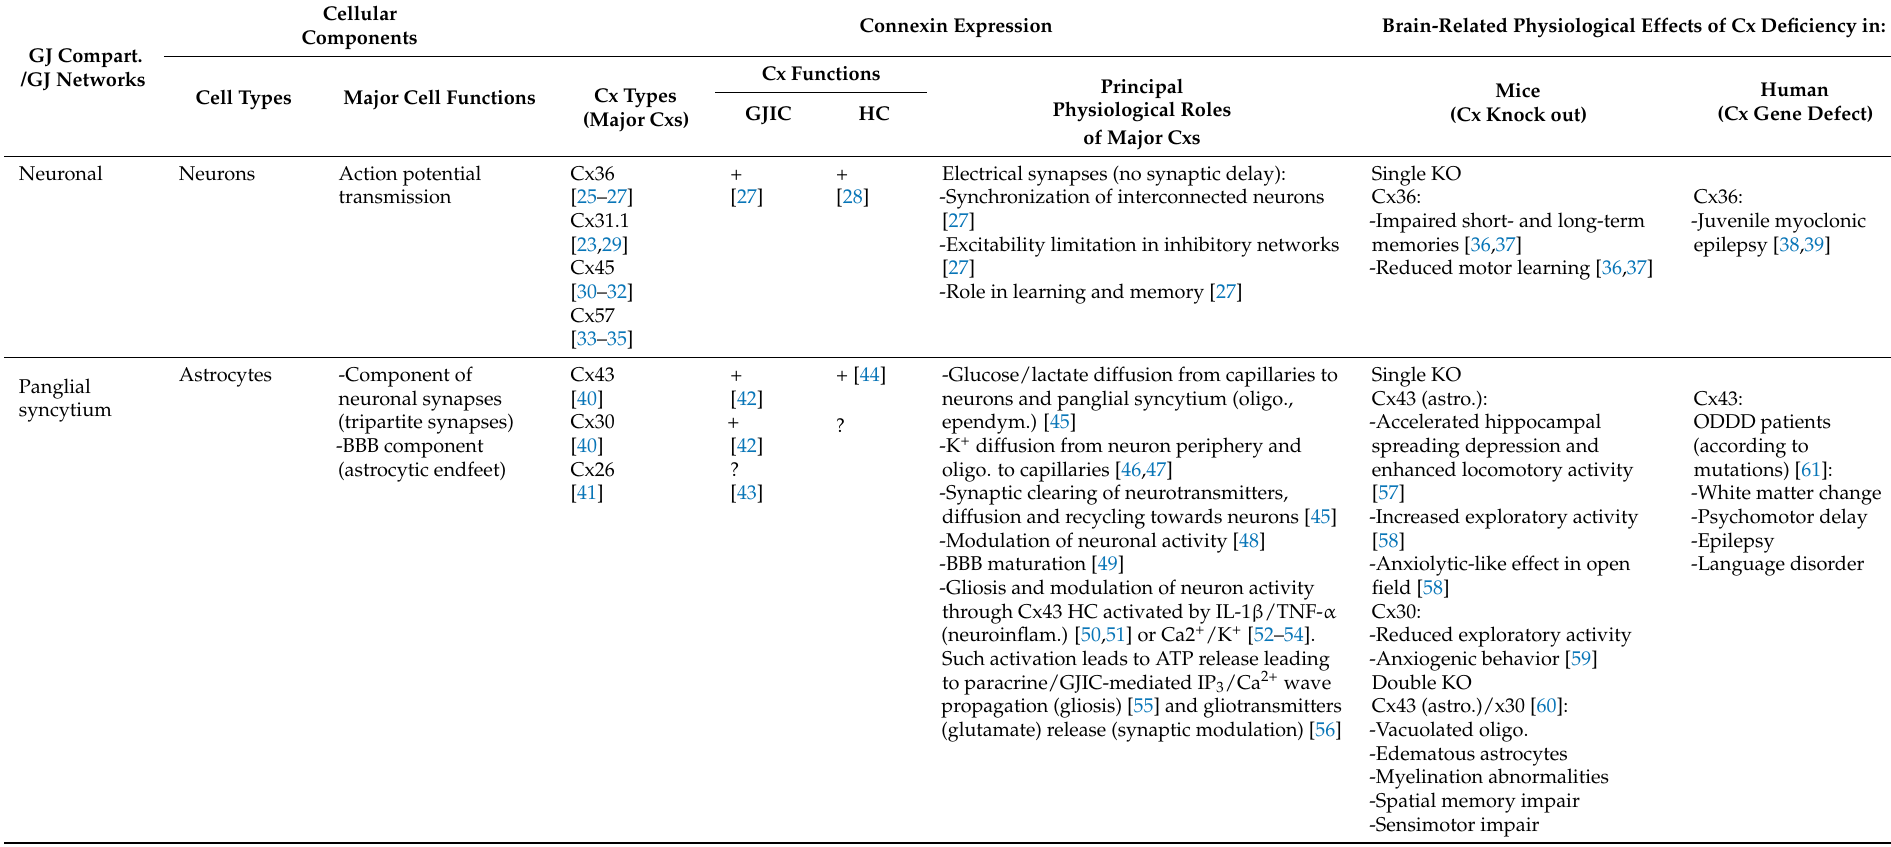
Table 2. Gap-junctional organization, connexin expression and functions in human adult brain. Stem cells are not included. Abbreviations: Astro., Astrocytes; BBB, Blood-brain barrier; CMT1X, X-linked Charcot-Marie-Tooth disease type 1; Compart., Compartments; Cx, Connexin; Ependym., Ependymocytes; Endo., Endothelial; GJ, Gap junction; GJIC, Gap-junctional intercellular communication; HC, Hemichannel; KO, Knock out mice; Neuroinflam., Neuroinflammation; NPC, Neuronal progenitor cells; ODDD, Oculodentodigital dysplasia; Oligo., Oligodendrocytes. References are indicated between brackets. In some cases, connexin function as GJIC and/or HC is questioned (?) because not proven yet